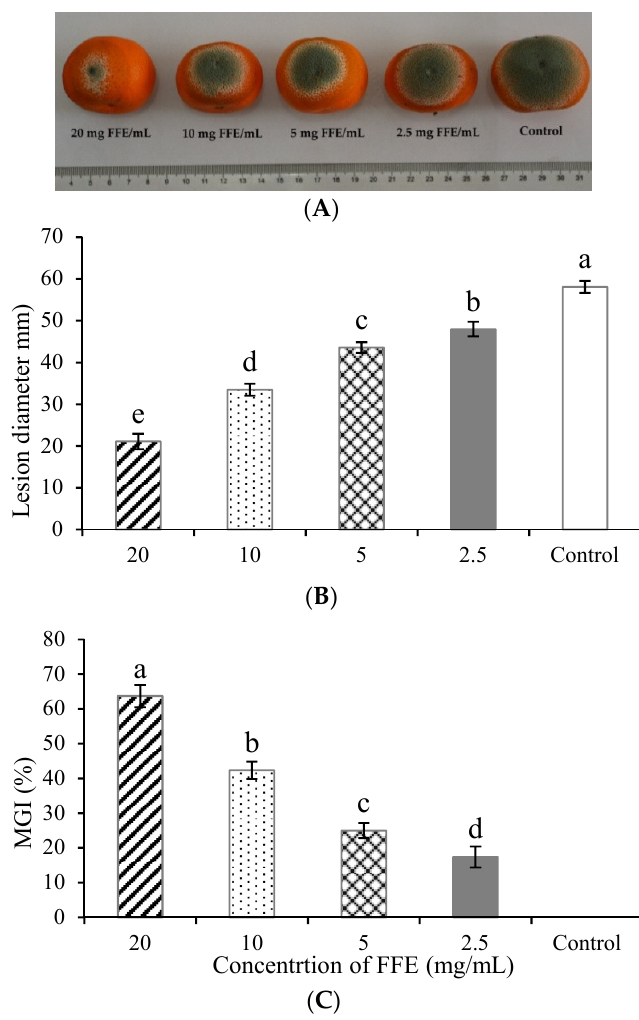
Figure 1. Antifungal efficacy of Ficus hirta Vahl. fruits extract (FFE) on in vivo mycelial growth of Penicillium italicum in Xinyu tangerines. Disease development ( A ), lesion diameter ( B ), and MGI ( C ) were measured after 7 days of incubation at 25 °C. Bars indicate the mean of fifteen fruits ± standard deviation (SD) and means labeled with different letters were significantly different according to Duncan’s multiple range test at P < 0.01.